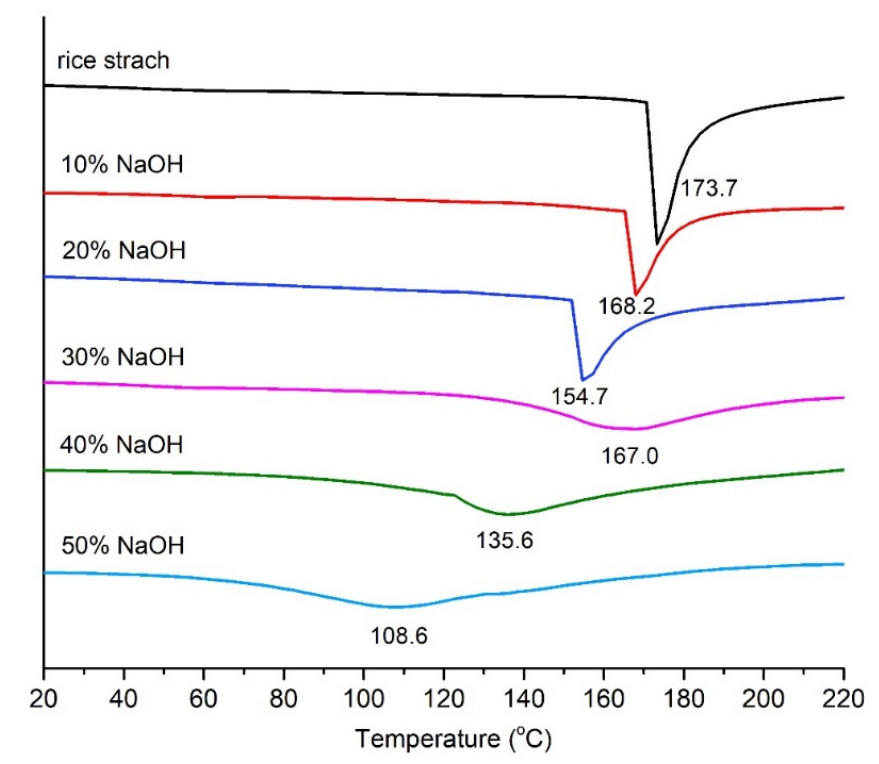
Figure 5. DSC thermograms of native rice starch film and CMSr films synthesized with 10%, 20%, 30%, 40%, and 50% NaOH concentrations.